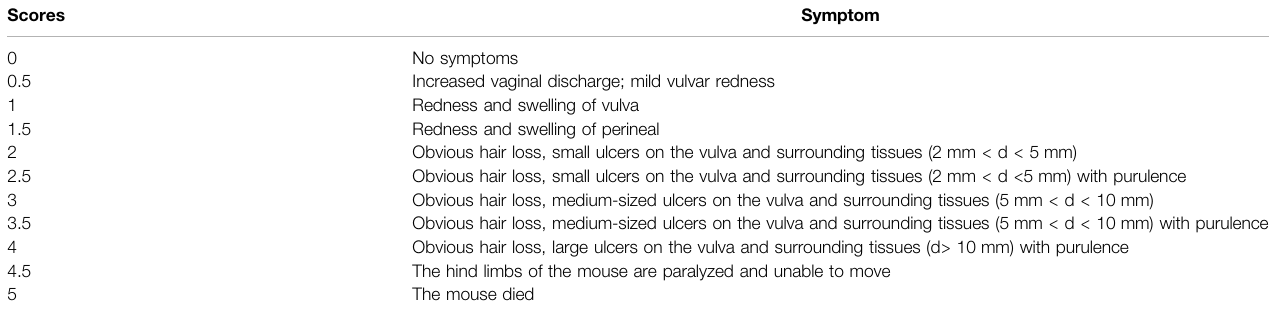
TABLE 2 | The details of symptom scoring.